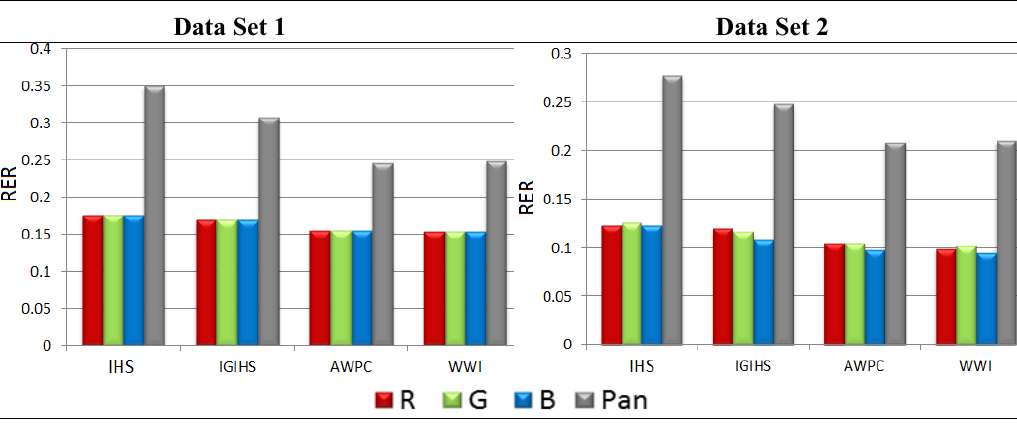
Figure 13. RER based Quality assessment of all pan-sharpening methods in both data